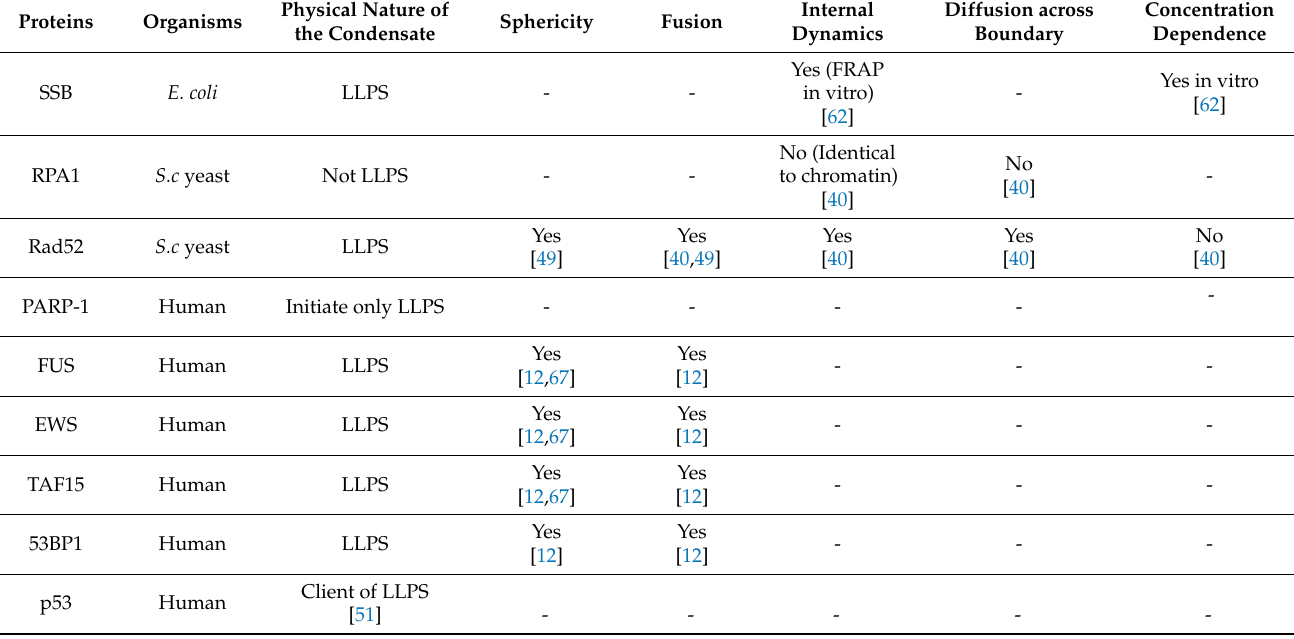
Table 1. List of repair proteins for which the physical nature of foci formed upon DSB was studied. For each protein, we precisely list which criteria were used to confirm or reject the LLPS model. The sign “-“ indicates that the criteria was not